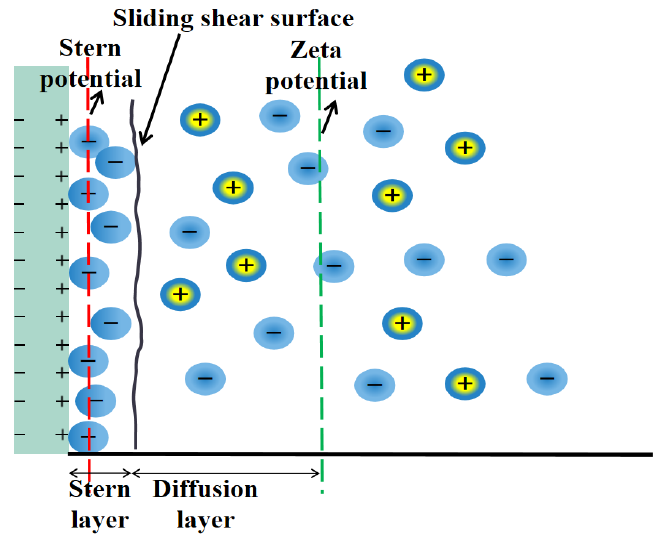
Figure 5. Electric double layer structure model.